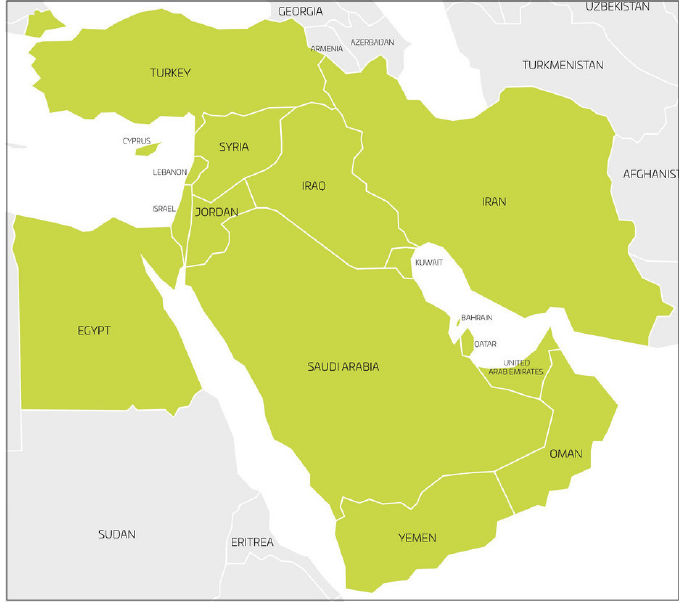
Figure 4. Middle Eastern countries covered in our dataset (highlighted in green).